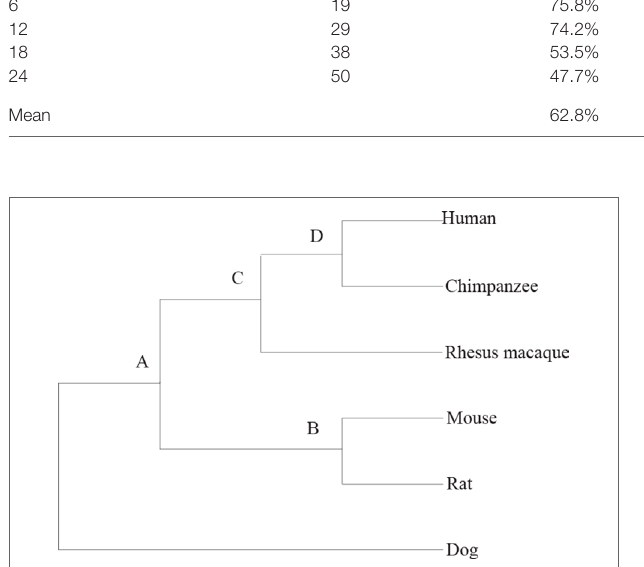
FIGURE 4 | The tree describing the phylogeny of mammalian species.